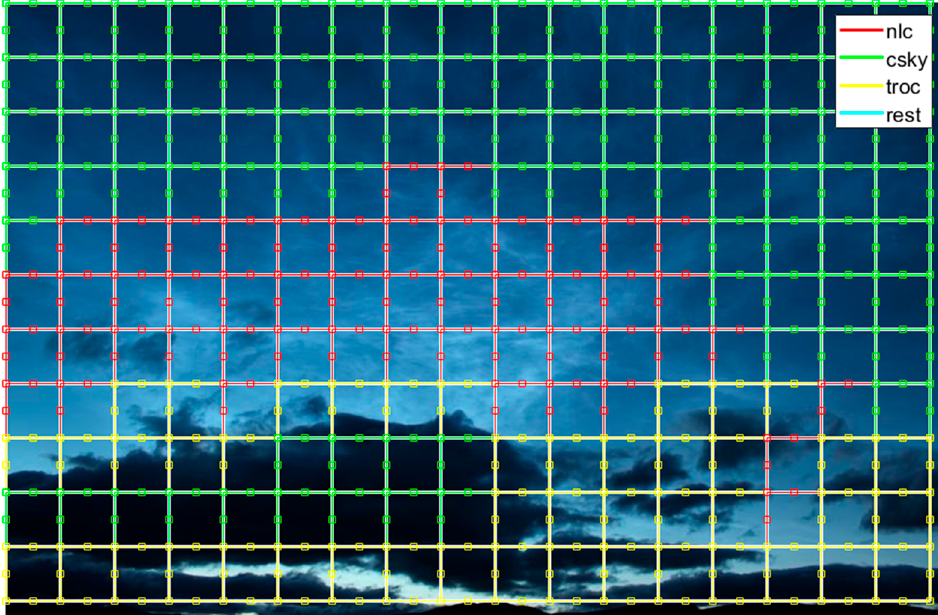
Remote Sens. 2019 , 11 , x FOR PEER REVIEW Figure 13. Very faint or low contrast noctilucent activity by the CNN algorithm.